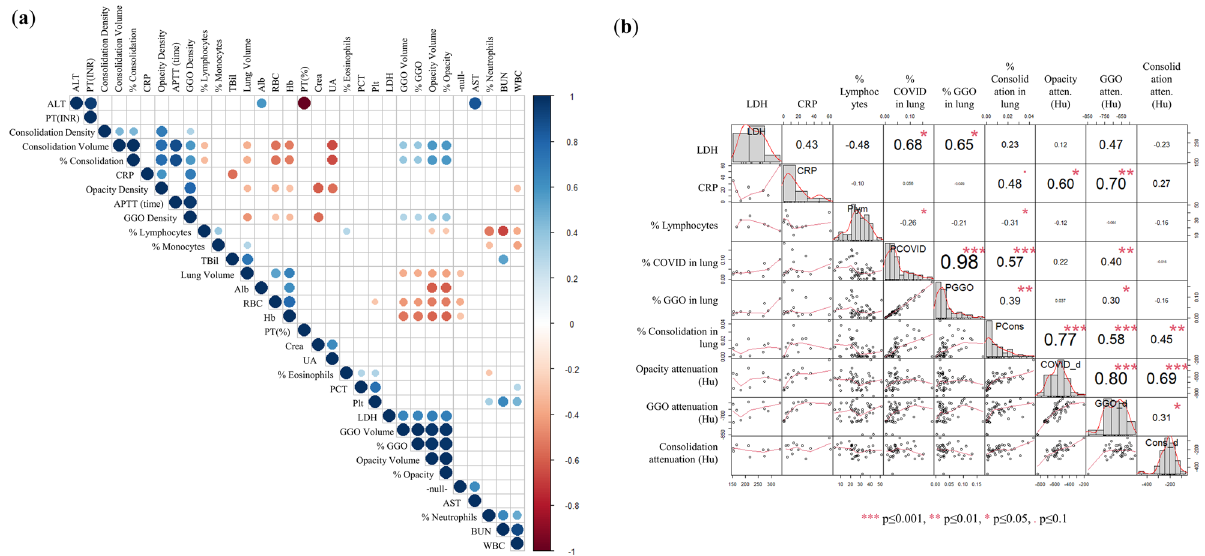
Figure 5. Correlation analysis between CT findings and laboratory measurements. ( a ) Correlation diagram heat map of all investigated CT features and laboratory measurements. Dots are present when p ≤ 0.05 and color represent either a positive (blue) or negative (red) correlation coefficient (r). ( b ) Detailed correlogram of features with strong correlation coefficients low probability coefficients (low p-values)